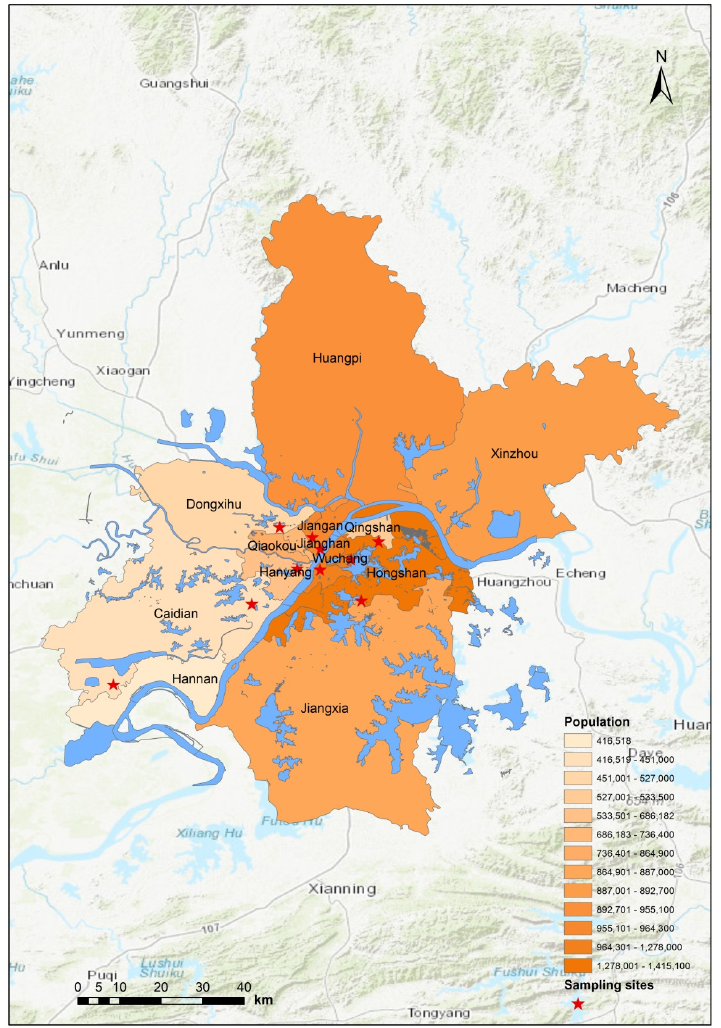
Figure 1. Map of Wuhan. The red pentagram represents monitoring stations. Population density by district is represented by gradient color.